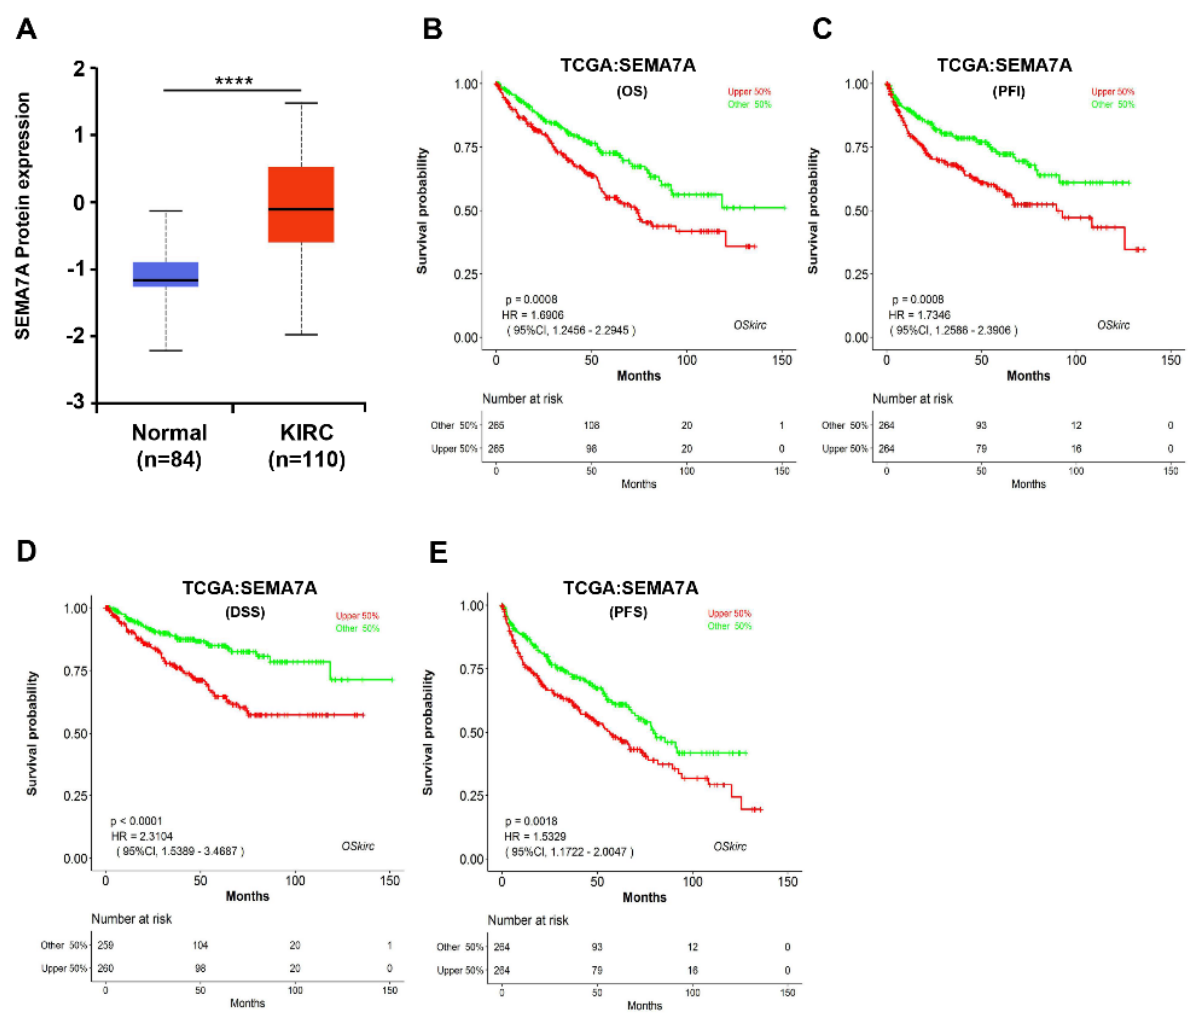
Figure 4. SEMA7A is highly expressed in KIRC cases and is associated with patients’ bad prognosis. ( A ) SEMA7A protein levels in normal and primary tumors. Log2 Spectral count ratio values from CPTAC were first normalized within each sample profile, then normalized across samples (****, p < 0.0001). ( B – E ) Kaplan–Meier curves of overall survival (OS), progression free interval (PFI), disease specific survival (DSS) and progression free survival (PFS) for KIRC patients with low and high SEMA7A mRNA expression. SEMA7A mRNA expression is associated with poor overall survival in the TCGA dataset of 523 KIRC patients ( p < 0.05). Table 2. Univariate and multivariate analysis of OS in patients with primary KIRC.